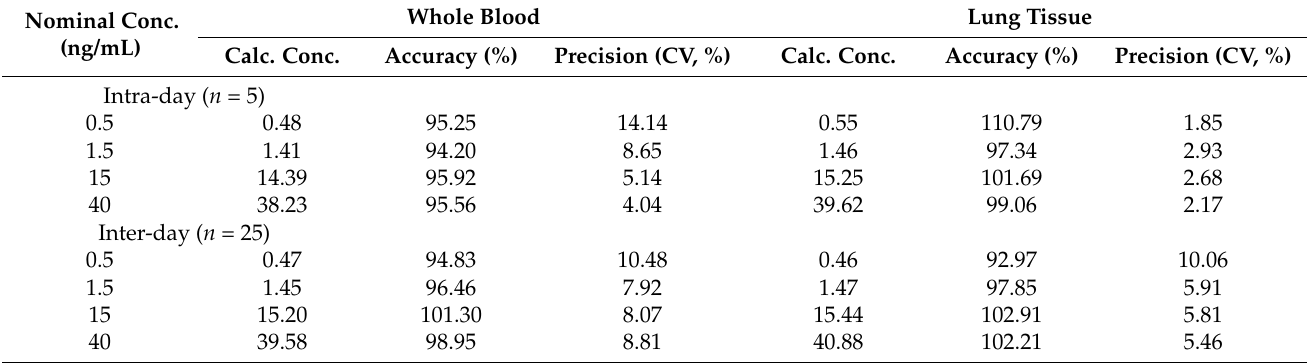
Table 2. Accuracy and precision of sirolimus in porcine whole blood and lung tissue samples. Nominal